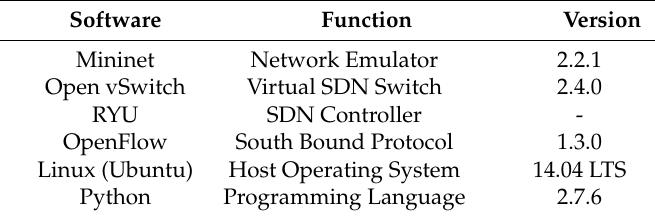
Table 3. Software used in the implementation and